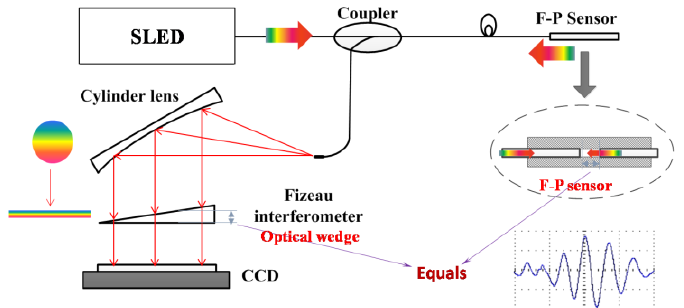
Figure 3. A schematic of the non-scanning correlation demodulation method. (SLED, super luminescent light emitting diode; CCD, charge coupled devices)